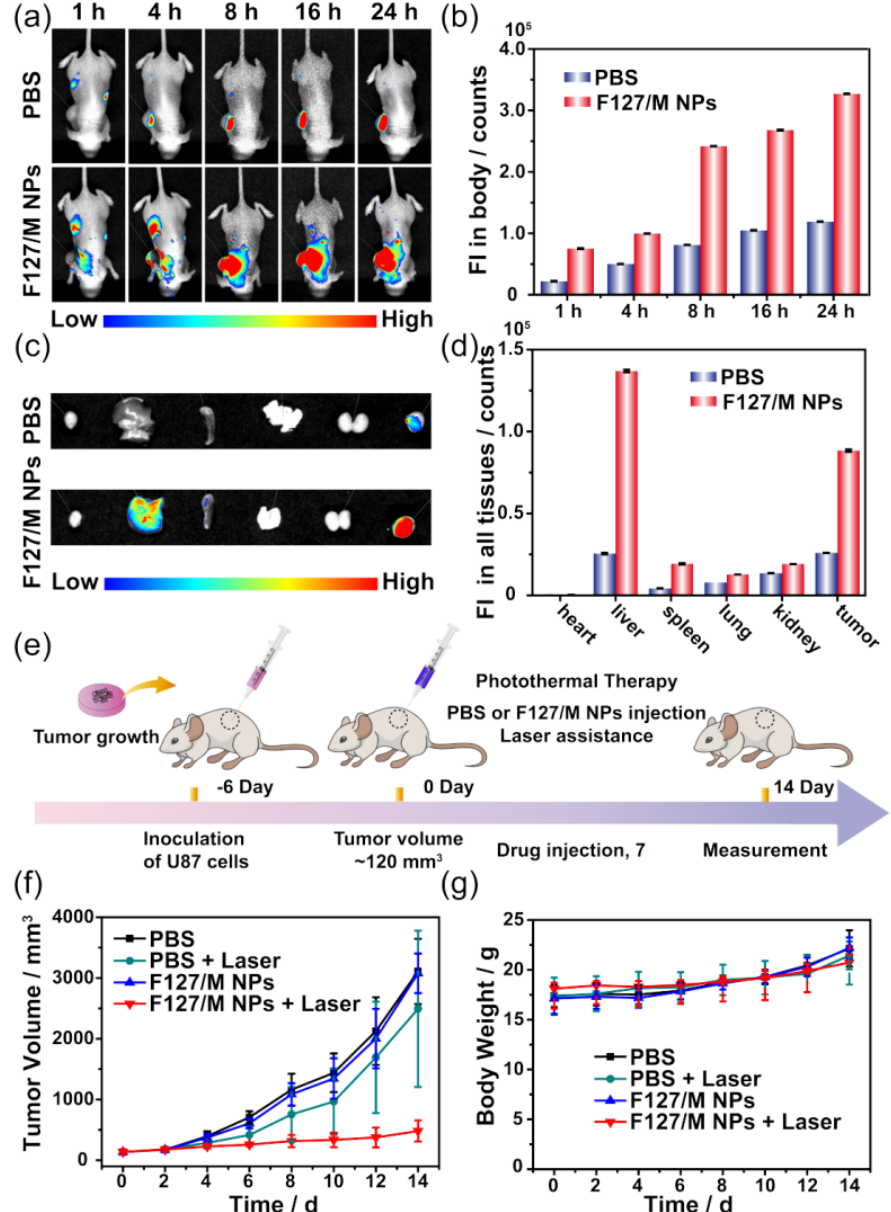
Figure 5. ( a ) Fluorescence images and ( b ) fluorescence intensities of tumor in U87 tumor-bearing mice at different time intervals (1, 4, 8, 16, and 24 h) after treatment with PBS or F127/ M NPs. ( c ) Ex vivo fluorescence imaging and ( d ) ex vivo fluorescence intensities of a tumor and of the major organs (i.e., heart, live, spleen, lung, and kidney) after treatment with PBS or F127/ M NPs. ( e ) Schematic illustration of the in vivo treatment process. Changes in the ( f ) tumor volume and ( g ) body weight of the U87 tumor - bearing mice in the different treatment groups.